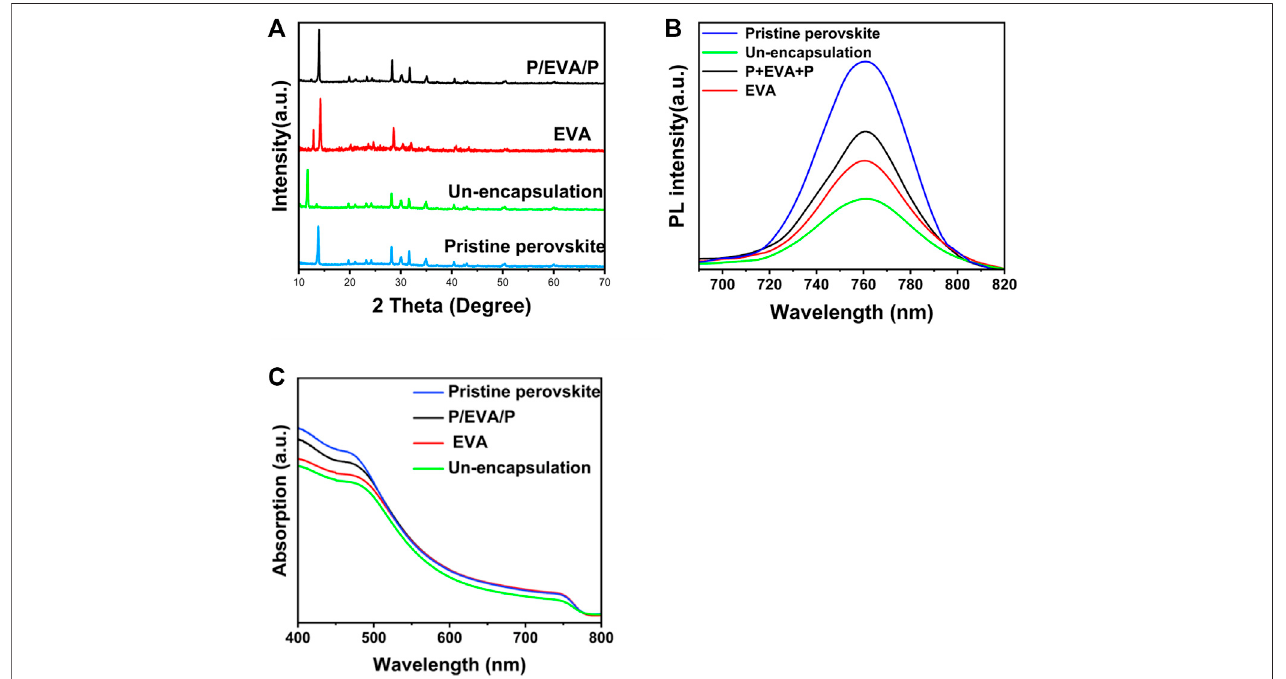
FIGURE5| EvolutionofXRDpatterns (A) ,steady-statePLspectra (B) andUV-visabsorptionspectra (C) forperovskite fi lmswithdifferentencapsulationstructures aged for 5 days at RH 75% and room temperature.